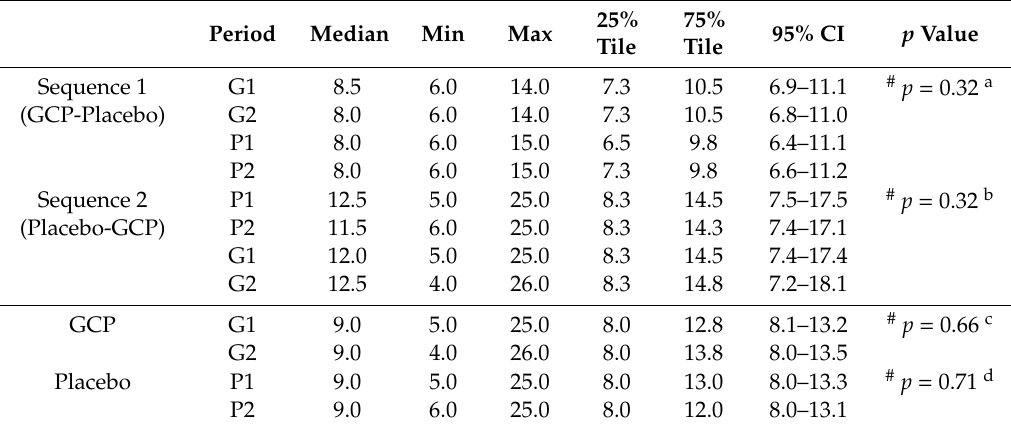
Table 3. Number of fungiform